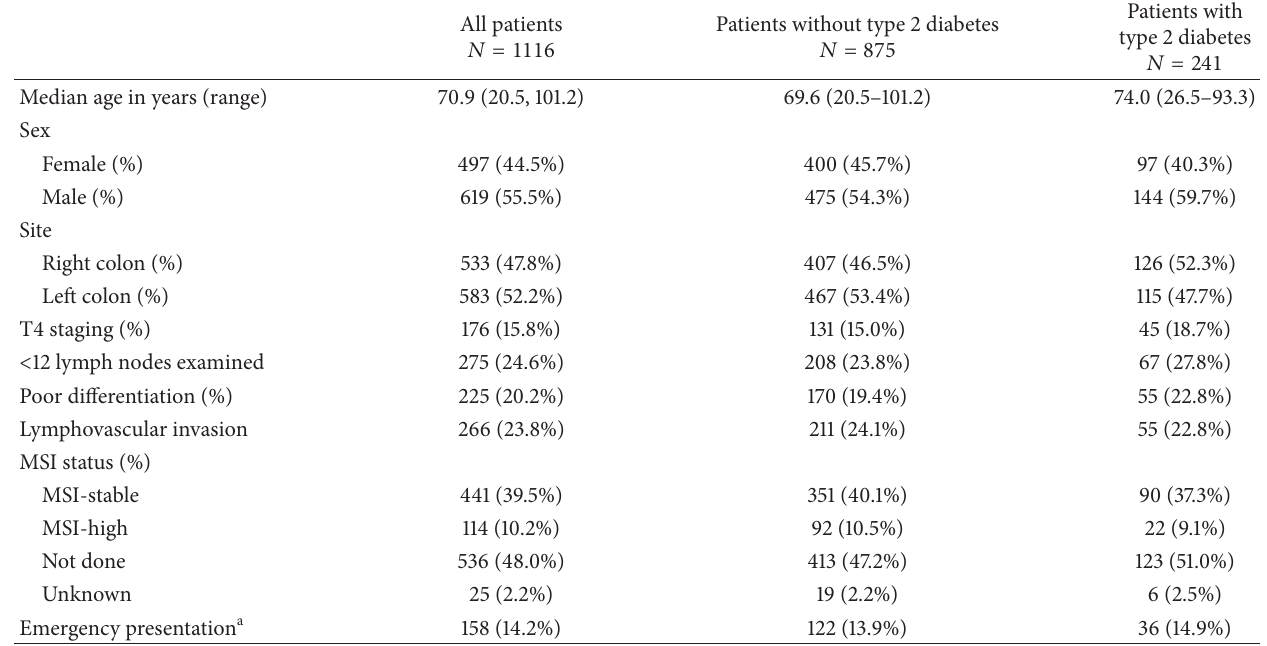
Table 1: Clinicopathological features of nondiabetes versus diabetes patients.